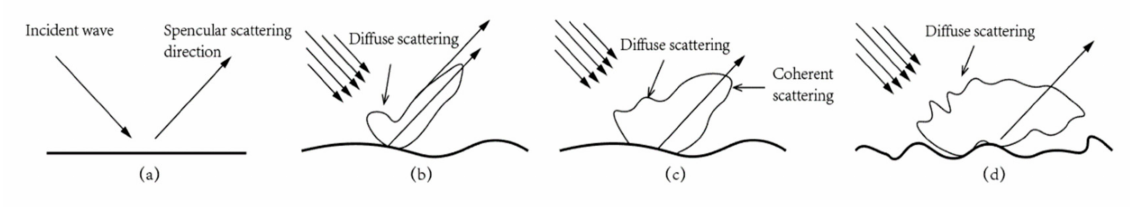
Figure 2. Electromagnetic wave scattering from several different rough surfaces. ( a ) specular surface.; ( b ) slightly rough surface; ( c ) medium rough surface; ( d ) rough